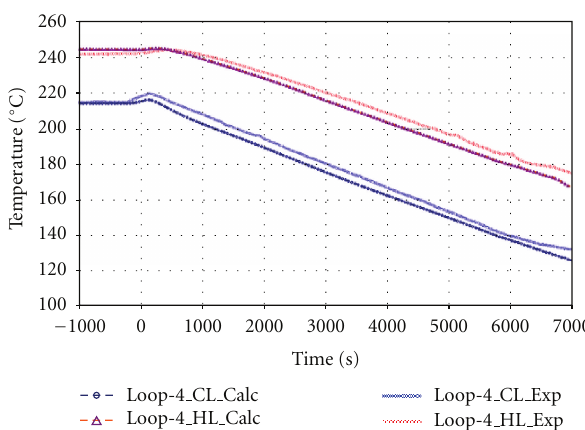
Figure 5: Run-1: Cold and hot leg temperature evolution in the active